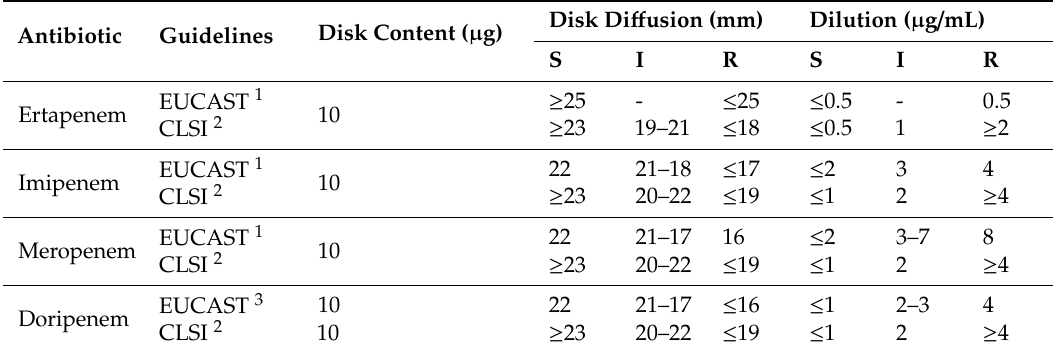
Table 2. Breakpoints for carbapenems against Enterobacteriaceae